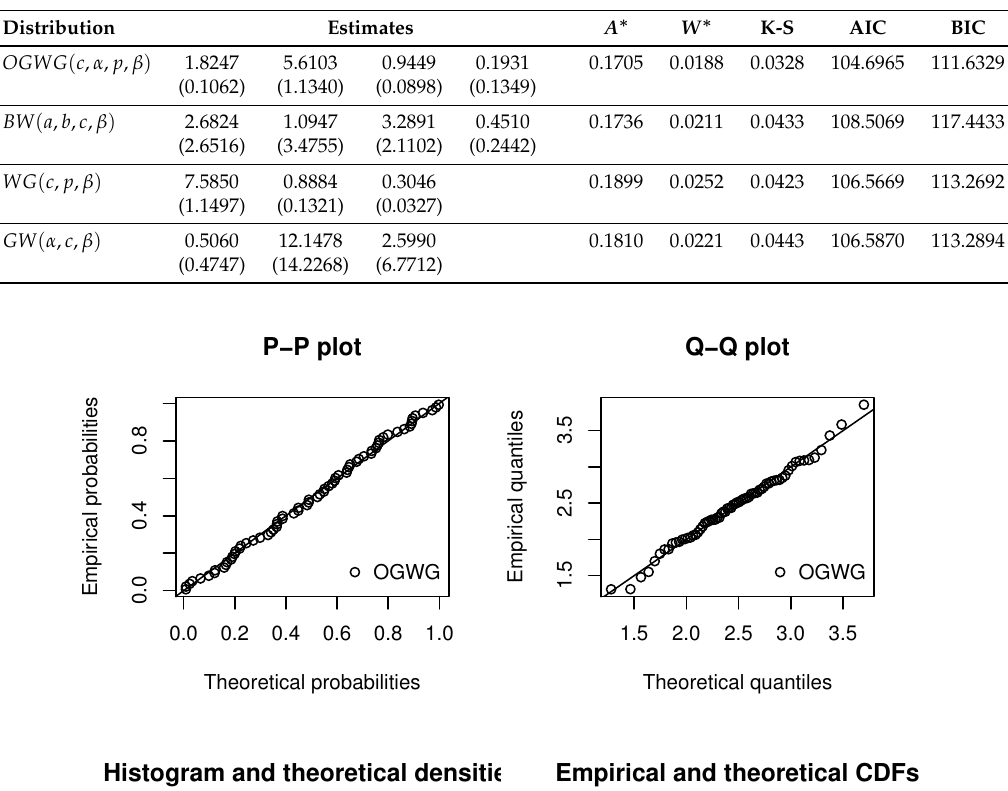
Table 7. MLEs, their SEs (in parentheses) and goodness-of-fit measures for data set 2.